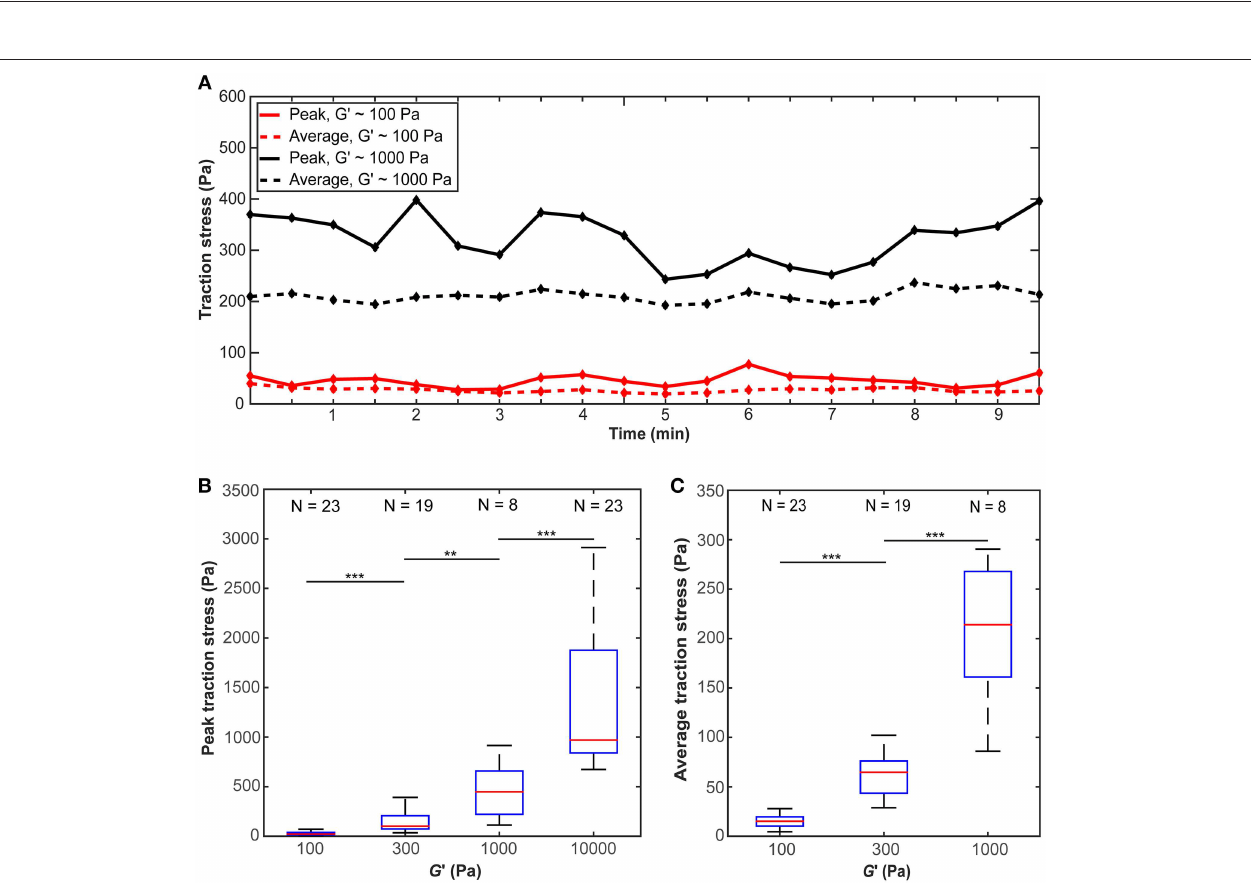
FIGURE 4 | Microglial cells exert larger forces on stiffer substrates. (A) Average and peak traction stress as a function of time for two representative cells on gels of G ′ ∼ 100 Pa and ∼ 1000 Pa. Traction stresses fluctuate over time. (B) Peak traction stress and (C) average traction stress as a function of substrate stiffness G ′ . Average traction stress values for a substrate stiffness of G ′ ∼ 10 kPa were excluded because most deformations were below our optical resolution limit. N: number of analyzed cells. ** p < 0 . 01 ; *** p < 0 . 001 .